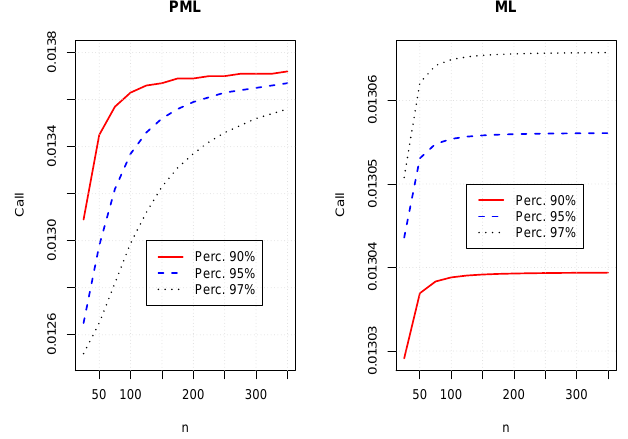
Figure 10. Call prices on P ( n ) ( 5,10 ) , α = 0.5 and 0.9; β = 1.5; λ 1 = 0.5; η 1 = − 0.002; σ 1 = 0.01. ML and PML kernels with n = 40 atoms.